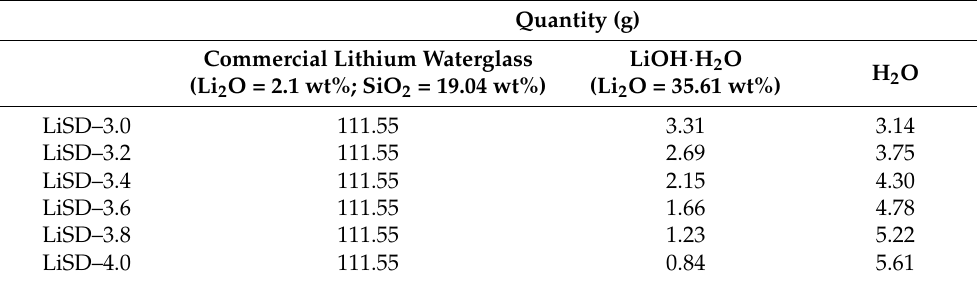
Table 1. Preparation proposal of 100 mL lithium silicate densifiers.